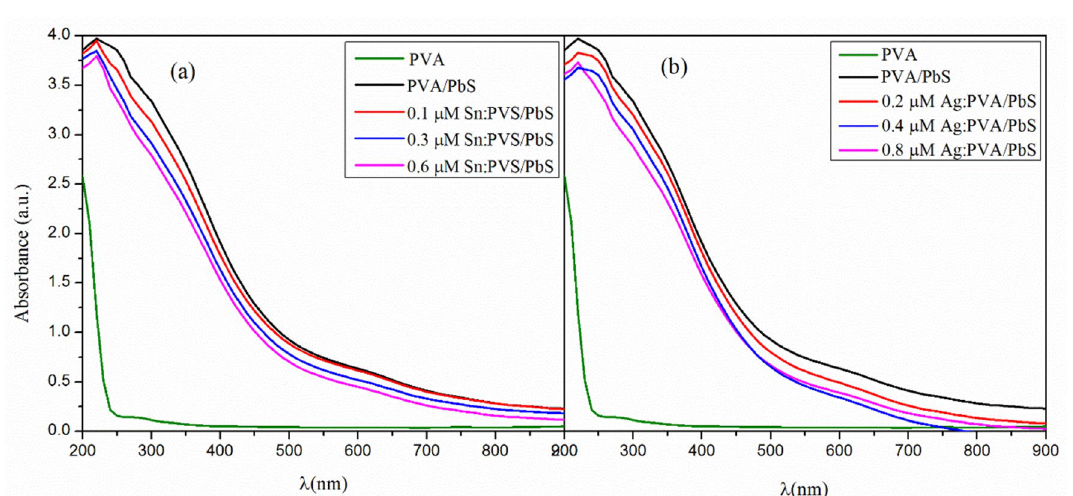
Figure 5. Optical absorption spectra for ( a ) Sn:PbS/PVA ( b ) Ag:PbS/PVA with PVA and pure